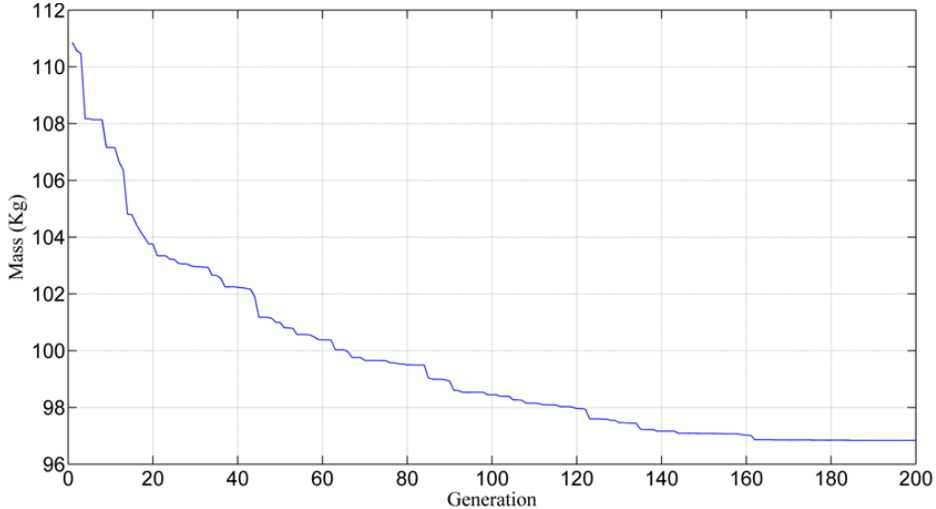
Figure 10. The convergence of object function. Table 11. The initial bounds and optimized values of the design